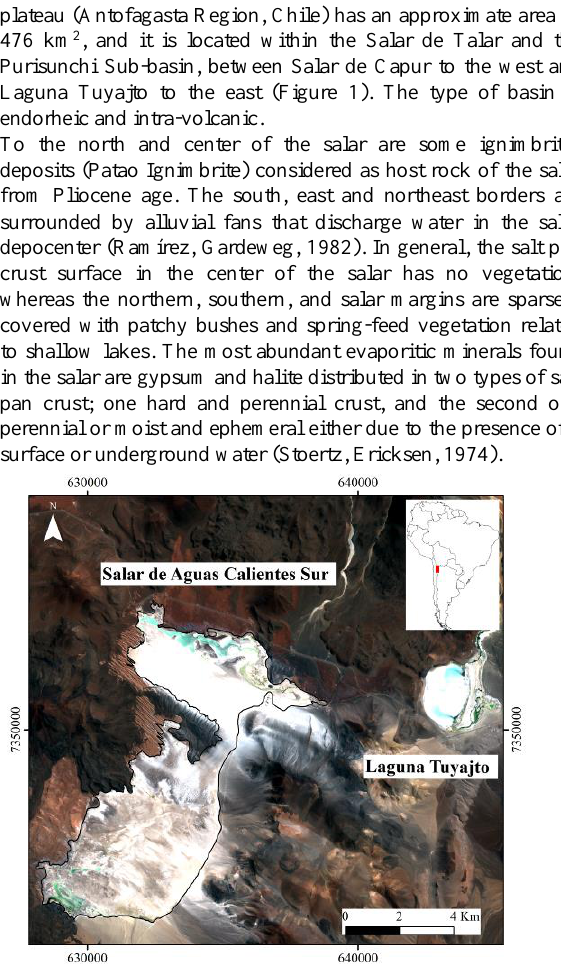
Figure 1. Study area. Sentinel-2B, true colour 432 RGB, 04-03- 2018 showing dry salt pans with high reflectance of salts (white) and lagoons (cyan). (Coordinate system: WGS84-UTM- 19 S).